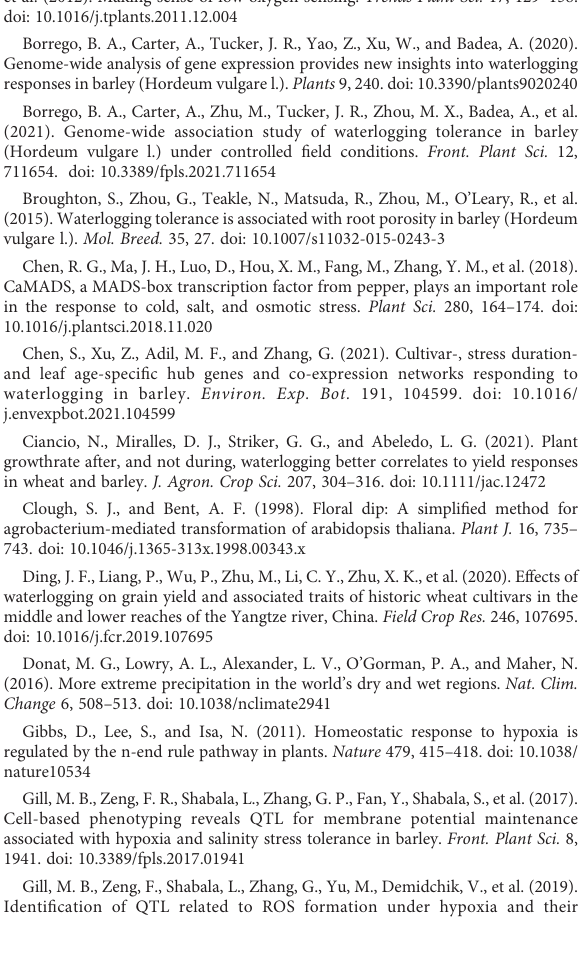
SUPPLEMENTARY FIGURE 2 Population structure of the 250 accessions. (A) Neighbor-joining tree of all250barleyvarieties. (B) Principalcomponentanalysisof250accessions based on genotype. (C) Population structure of the 250 accessions based on STRUCTURE when K = 2. SUPPLEMENTARY FIGURE 3 Manhattan plots resulting from the SNP-based GWAS in waterlogging treatment under different periods. Manhattan plots for 2019 WLS-1, 2019 WLS-2, 2019 WLS-3, 2019 WLS-4, 2020 WLS-1, 2020 WLS-2, 2020 WLS- 3, 2020 WLS-4 were shown in (A-F) , respectively. The x-axis shows SNP loci along the seven barley chromosomes. The horizontal red line shows the genome-wide signi fi cance threshold P-value of – log10 (P-value) value of 4.0. GWAS was performed using the GLM (Q + K) model. SUPPLEMENTARY FIGURE 4 GO functional enrichment analysis of DEGs in the roots of two barley varieties under the waterlogging and control treatments. (A) TX9425 at 72h after waterlogging refer to Control; (B) Franklin at 72h after waterlogging refer to